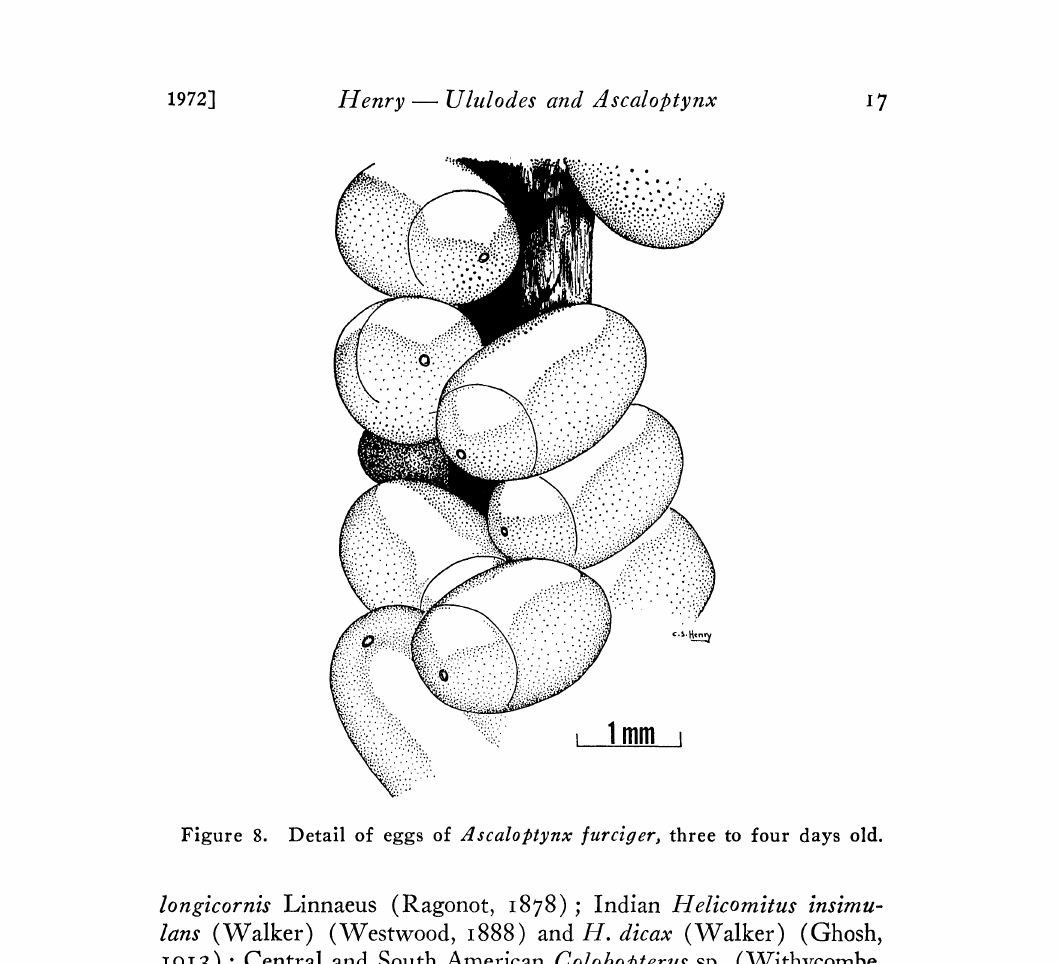
Figure 8. Detail ot eggs of Ascaloptynx furciger, three to four days old. longicornis Linnaeus (Ragonot, 878); Indian Helicomitus insimu- lans (Walker) (Westwood, 888) and H. dicax (Walker)